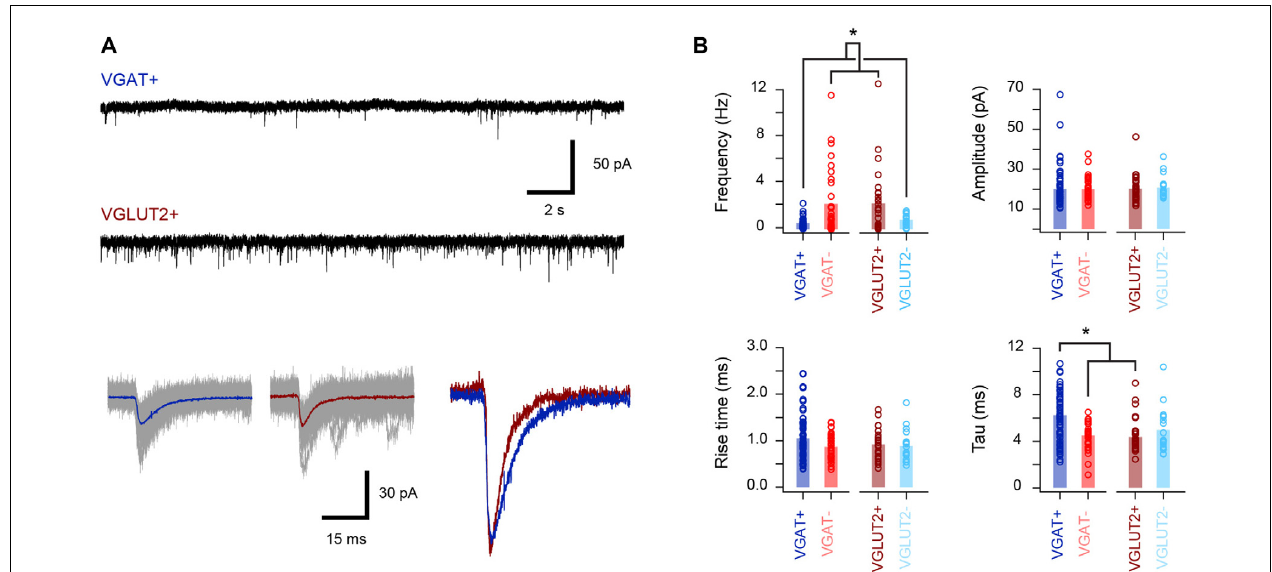
FIGURE 4 | Properties of the excitatory synaptic drive to excitatory and inhibitory populations. (A) Upper traces show representative voltage-clamp recordings from inhibitory (vGAT+) and excitatory (vGLUT2+) neurons (holding potential − 70 mV). Note the higher frequency of spontaneous excitatory postsynaptic currents (sEPSCs) in the excitatory neuron recording. Lower traces show overlaid sEPSCs captured from the above recordings with averaged currents shown as colored traces. Right traces are averages from a VGAT+ (blue) and VGLUT2+ (red) neuron scaled to the same amplitude. Note the faster sEPSCs decay kinetics in the excitatory neuron. (B) Group data plots comparing sEPSC properties for inhibitory and excitatory neurons. Consistent with representative traces in (A) , sEPSC frequency was significantly higher in excitatory neurons (VGLUT2+ and VGAT − ), while sEPSC decay kinetics were slower in recordings from inhibitory cells (VGAT+ and VGLUT2 − ). In contrast, sEPSC amplitudes and rise times were similar across the four neuron groups. * p < 0.05.